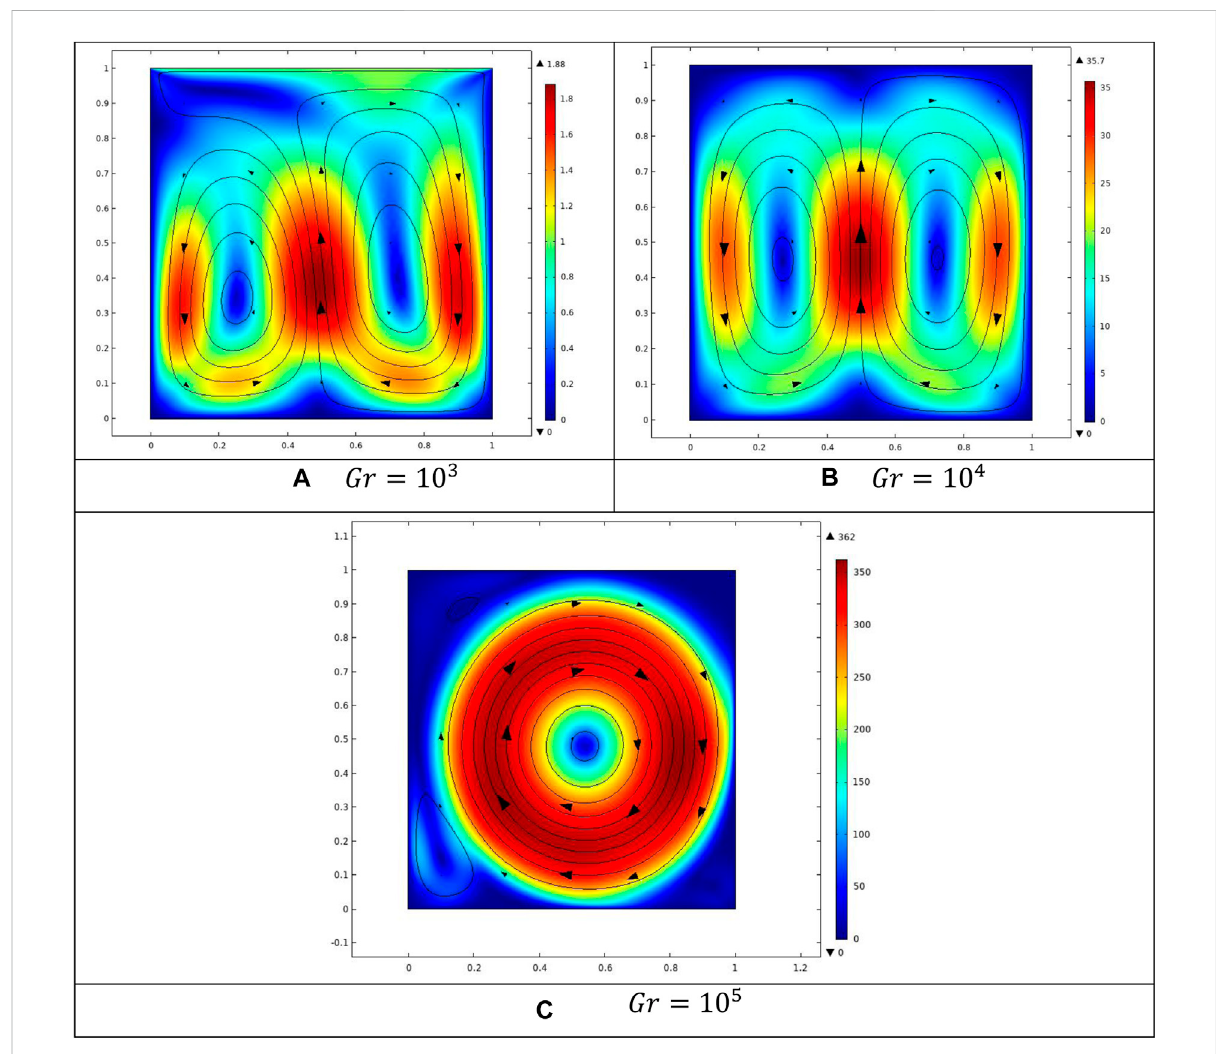
FIGURE 5 In fl uence of Gr on streamlines for the uniform heated case: (A) Gr (cid:1) 10 3 , (B) Gr (cid:1) 10 4 , and (C) Gr (cid:1) 10 5